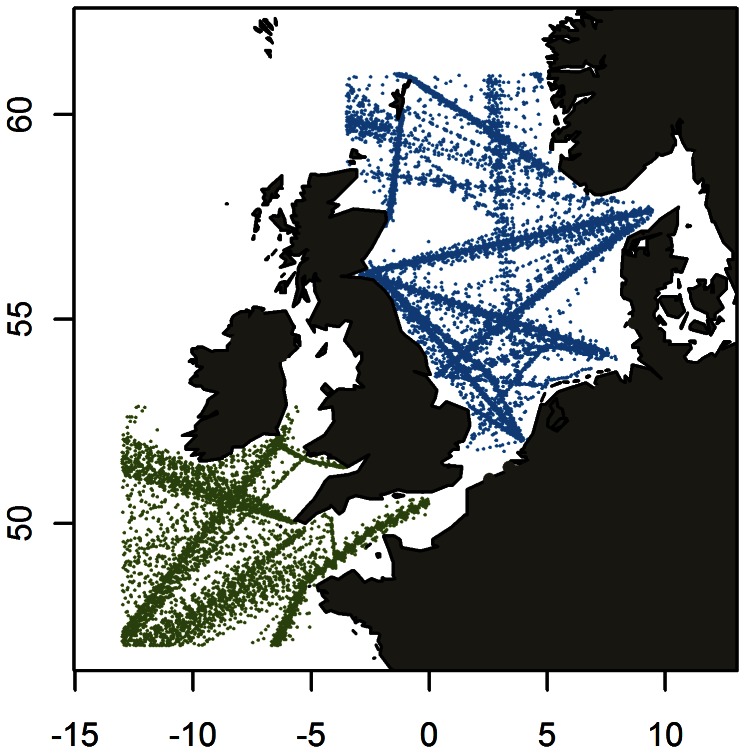
Continous plankton recorder samples from 1955–1974 in the studied areas.